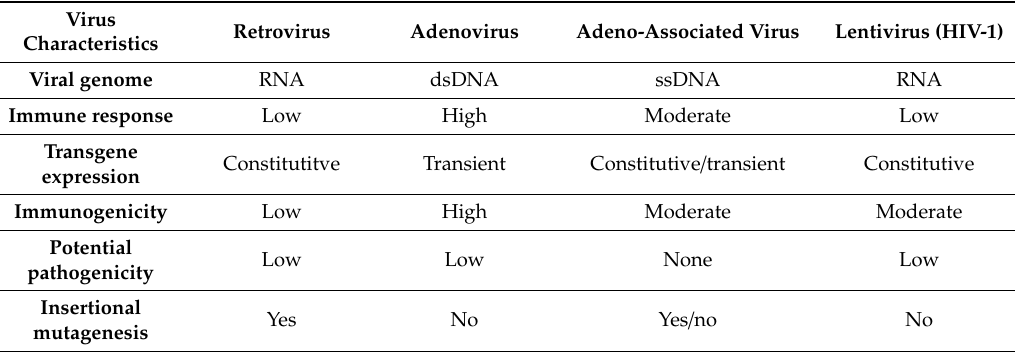
Table 2. The main features of viral